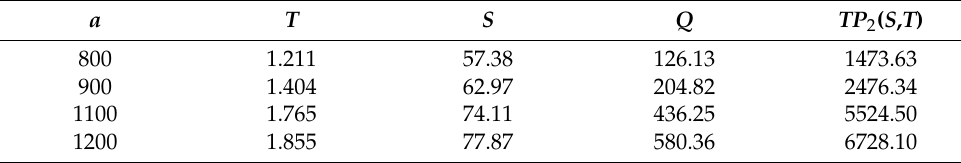
Table 3. Impact of market potential ( a ) .